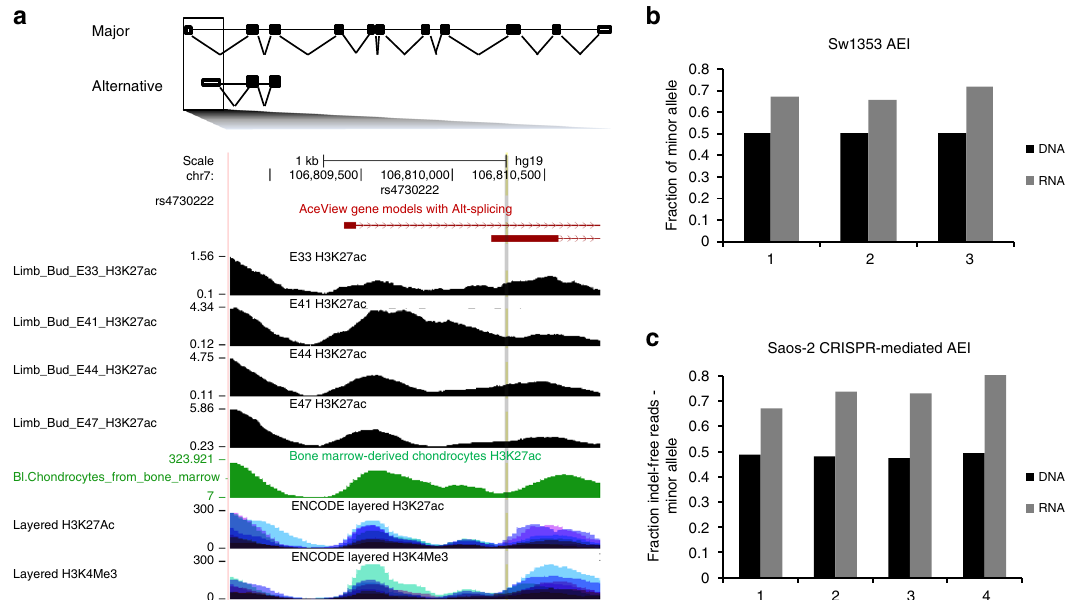
Fig. 3 Functional validation of rs4730222. a Gene model of HBP1 ensemble isoform ENST00000468410 (major) and ENST00000497535 (alternative). UCSC genome browser zoomed in to the two transcriptional start sites 57 . Rs4730222, within the 5 ′ -UTR of the alternative transcript, is indicated by a vertical gray line traversing the annotation tracks. The four black tracks are H3K27ac performed in human embryonic limb bud at E33, E41, E44, and E47, respectively 28 . The green track is H3K27ac data from chondrocytes derived from cultured bone marrow mesenchymal stem cells 29 . Layered H3K27ac is H3K27ac ChIP-seq (a marker for active enhancers and active promoters) layered from GM12878, H1-hESC, HSMM, HUVEC, K562, NHEK, and NHLF cells. Layered H3K4me3 is H3K4me3 ChIP-seq (marker for active promoters) layered from the same seven ENCODE cell lines. b Allelic expression imbalance in SW1353, a chondrosarcoma cell line heterozygote for rs4730222. Black bars represent the fraction of the minor allele in DNA, and gray bars indicate the fraction of the minor allele in cDNA. n = 3 independent experiments. c Allelic expression imbalance in Saos-2 cells with the minor allele of rs4730222 introduced through CRISPR-mediated HDR. Bars are the same as in Fig. 3B. n = 4 independent experiments. Source data are provided as a Source Data fi